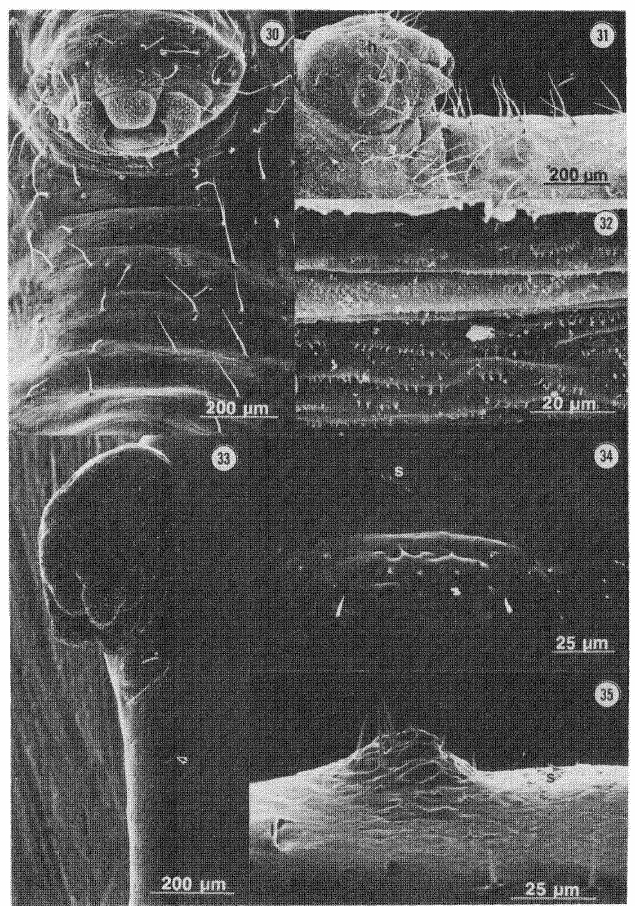
Figs. 30-35. Fig. 30. Ventral view of anteroventral region of Trachymyrmex septentrionalis. Note simple hairs (arrow). Fig. 31. Lateral view of anteroventral region of T. septentrionalis. Note simple hairs (arrow). Head (h). Fig. 32. Poste- riorly pointing ventral prothoracic spinules of T. septentrionalis. Fig. 33. Ventro- lateral view of anteroventral region of Atta texana. Note prothoracic boss (large arrow) and metathoracic leg vestige (small arrow). Fig. 34. Ventral view of protho- racic boss of A. texana. Note posteriorly pointing spinules (s) anterior to the boss. Fig. 35. Lateral view of prothoracic boss of A. texana. Note posteriorly pointing spinules (s) anterior to the boss, and left prothoracie leg disc